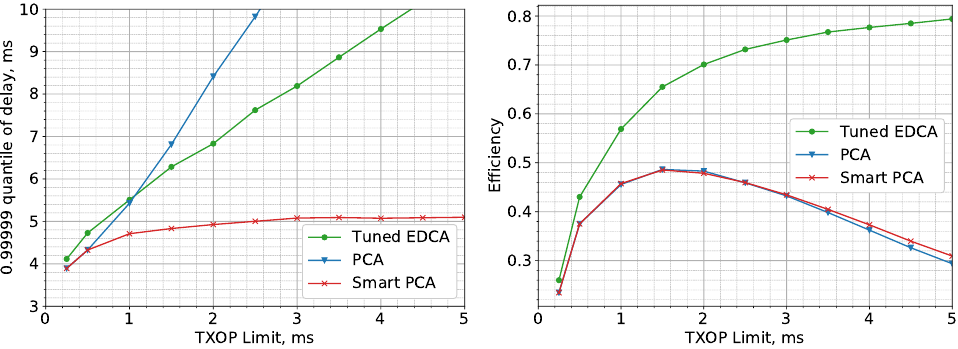
Figure 5. Delay quantile and efficiency vs. TXOP Limit in case of T period = 20ms, σ = 10µs, M =